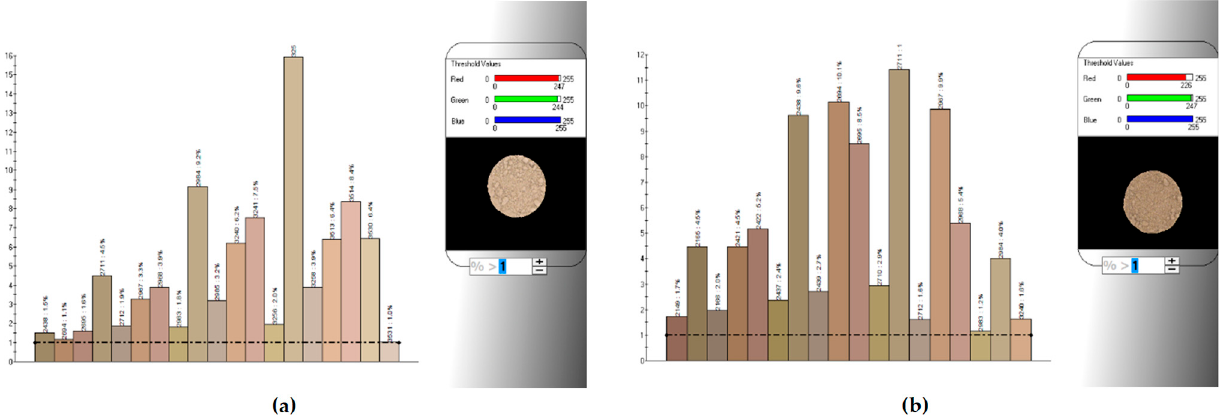
Figure 3. Graphical interpretation of the color distribution of powder obtained from mango seed using the instrumental method (‘electronic eye’); ( a ) CD powder; ( b ) FD powder.